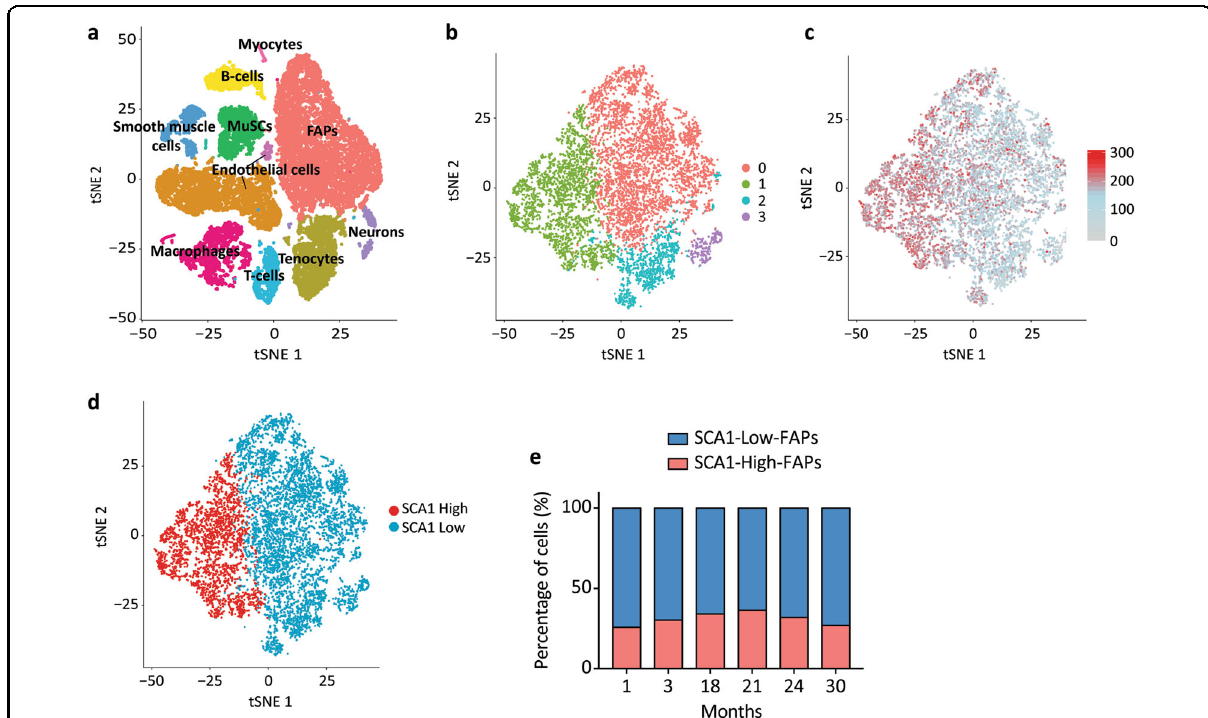
Fig. 7 FAP cell states from wild type mice differ in their transcriptional pro fi le. a viSNE map representing the different clusters identi fi ed as distinct cell populations according to the expression of speci fi c biomarkers. Identi fi ed populations are: myocytes, B-cells, FAPs, smooth muscle cells, MuSCs, endothelial cells, macrophages, T-cells, tenocytes and neurons. b The FAPs population subset has been re-clustered, leading to 4 distinct clusters according to their gene expression pro fi le. The four clusters (0, 1, 2,3) were mapped onto the viSNE map of FAPs. c The expression of SCA-1 antigen has been mapped to each cell of the dataset. d viSNE map of FAPs in which clusters 0, 2, 3 are collapsed together to obtain two clusters expressing high level (SCA-1 High) and low level (SCA-1 Low) of SCA-1. e Stacked bar plot showing the percentage of the two population on the basis of SCA-1 expression levels across different